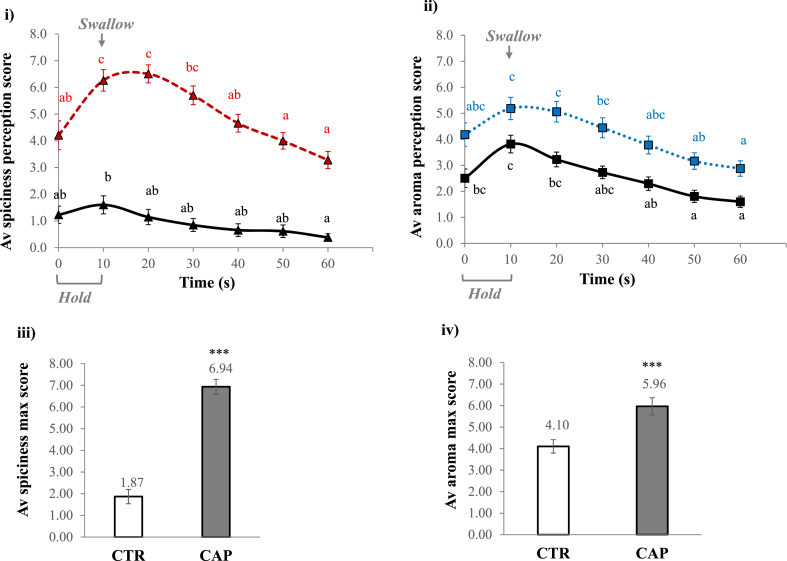
Impact of capsaicin on temporal aroma perception. i) spiciness perception scores over 60 s for CTR (black solid line with the triangle) and CAP (red dashed line with the triangle) and ii) aroma perception scores over time for CTR (black solid line with the square) and CAP (blue dotted line with the square) when solutions were held in the mouth for 10 s and swallowed after 10 s till 60 s. Different letters (a-c) indicated significant differences between time points (p < 0.05). Average data of iii) spiciness maximum score and iv) aroma maximum score for CTR (white bar) and CAP(grey bar); *** indicated a statistical difference of p < 0.0001. Data were based on the average of 15 participants x 3 reps for each sample. The standard error is shown as ± error bar. (For interpretation of the references to colour in this figure legend, the reader is referred to the Web version of this article.)